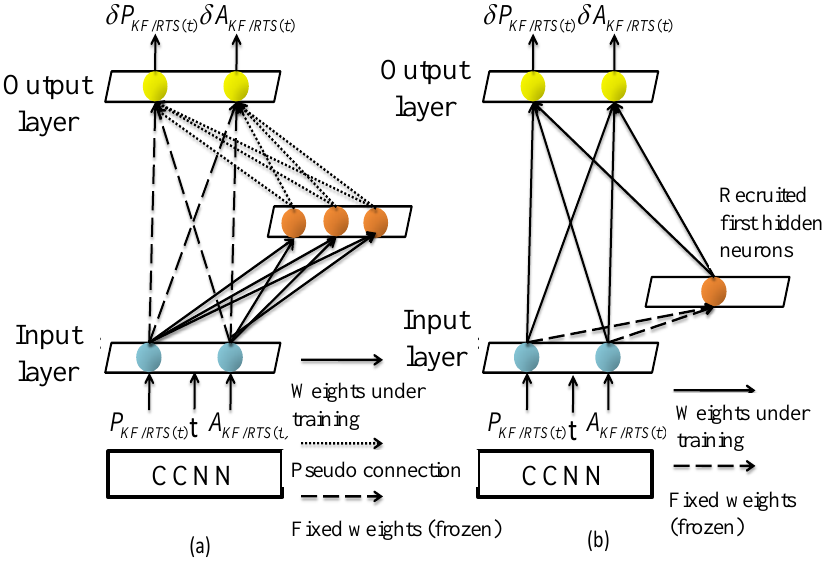
Figure 11. The recruitment and installation of the first hidden